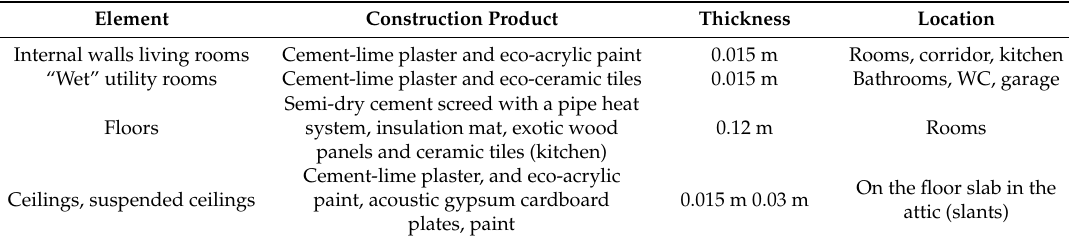
Table 4. Main finishing products used in indoor